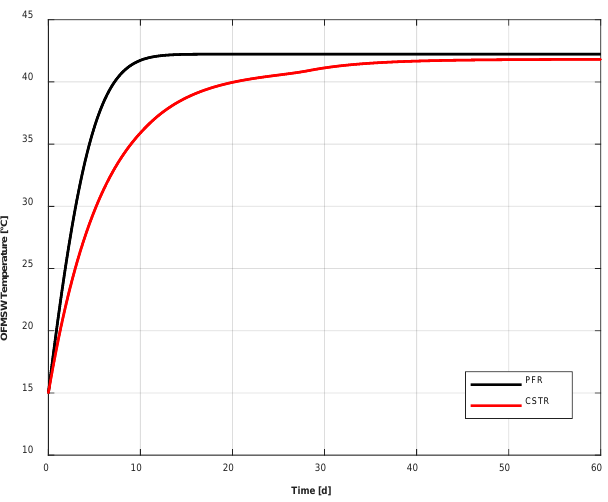
Figure 9. Comparison between the OFMSW Temperature in PFR and CSTR.